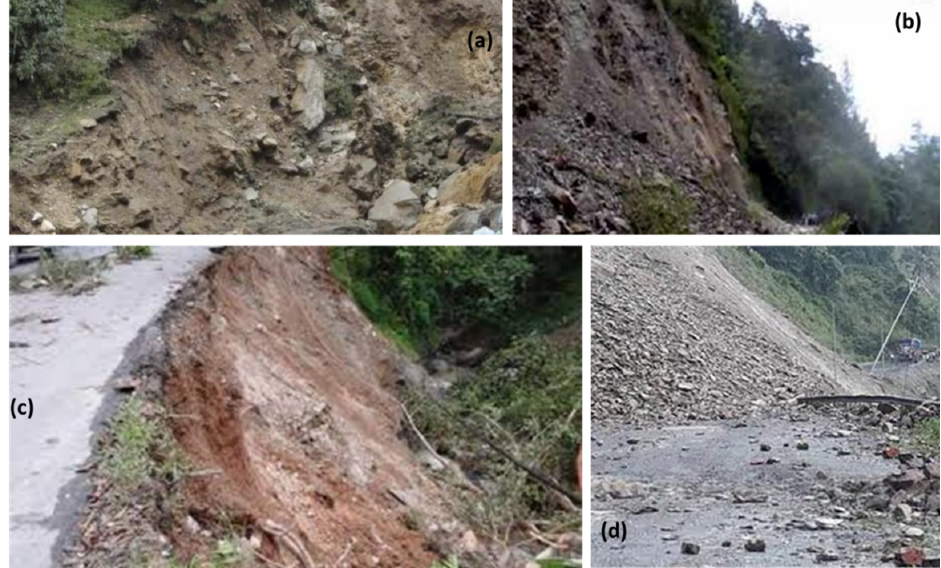
Figure 3. Field photographs of some selected landslide locations of the study area; ( a ) Gangtok Forest Block (27°22 ′ 20.07 ′′ N and 88°40 ′ 32.60 ″ E); ( b ) Jawarharlal Nehru Marg Road (27°22 ′ 16.77 ″ N and 88°40 ′ 36.21 ″ E); ( c ) Tadong area (27°18 ′ 31.60 ″ N and 88°36 ′ 24.91 ″ E); and ( d ) Jawarharlal Nehru Marg Road (27°21 ′ 57.71 ″ N and 88°39 ′ 14.47 ″ E).